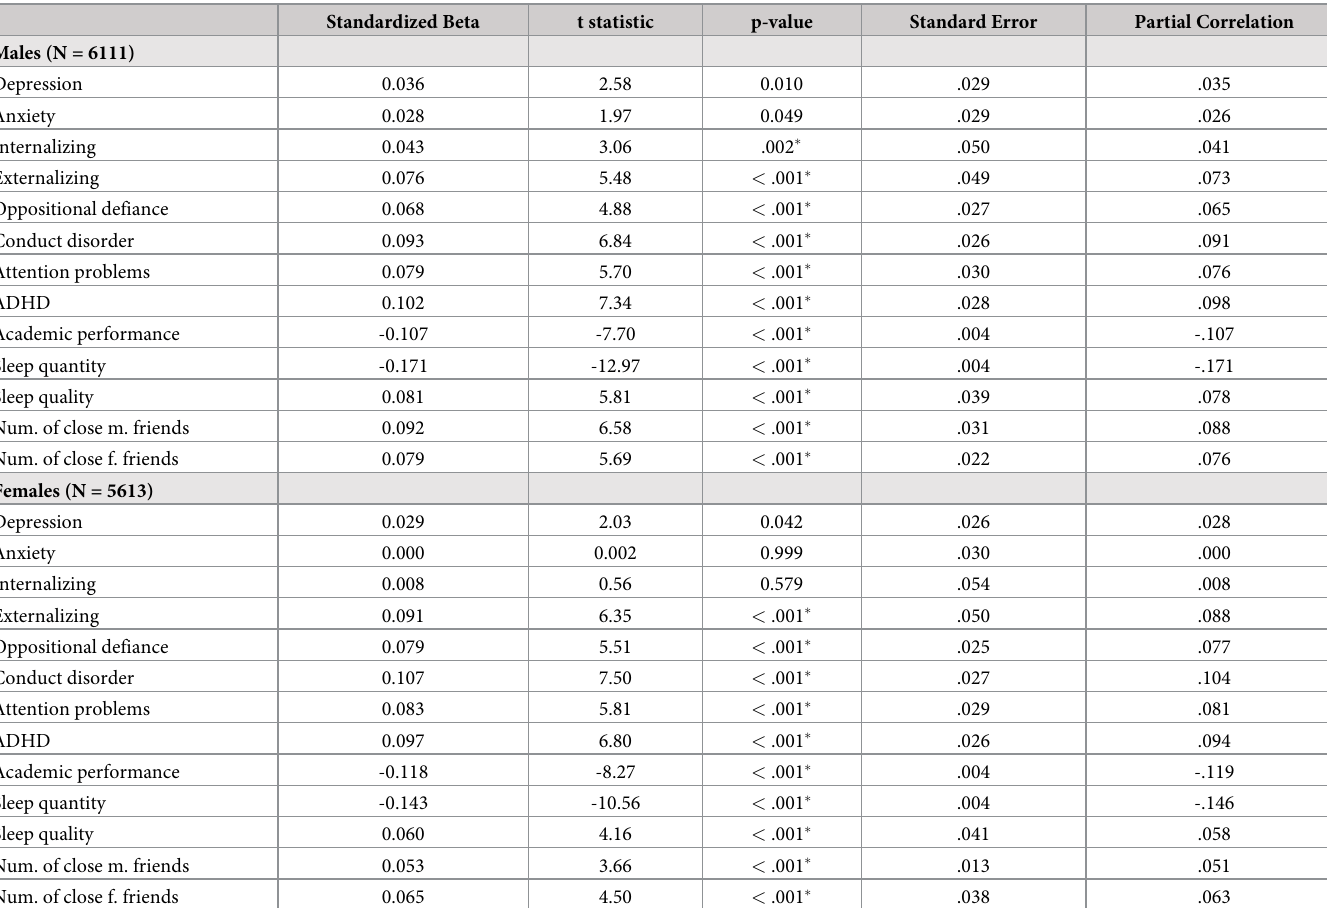
Table 3. Outcome measures regressed on weekday total screen time for Part 1, controlling for SES and race/ethnicity, separated by